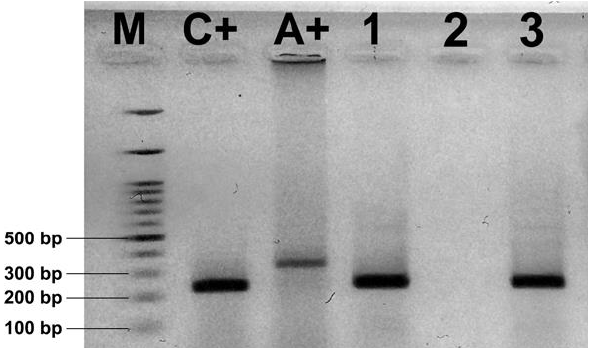
Figure 3. Ethidium-bromide-stained agarose gel showing the results of duplex PCR using primers 321APIS-for / rev and 218MITOC-for / rev for di ff erential diagnostics of N. ceranae / N. apis . L—100 bp ladder DNA marker; C + positive N. ceranae control; A + , positive N. apis control; 1–3, tested